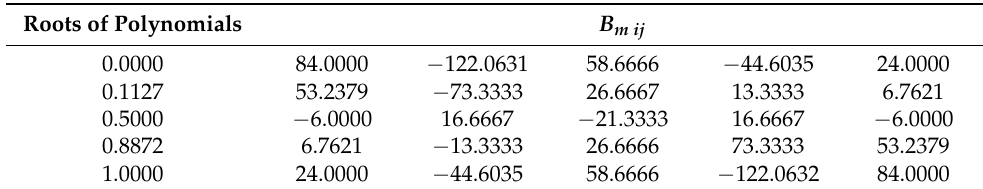
Figure 6. Distribution of some of the N internal collocation points and N + 1 boundary nodes. Table 2. Array of orthogonal collocation points and Matrix Bm for an asymmetric planar geometry, j and i being counters that indicate the contribution from each collocation point to a specific one, respectively.